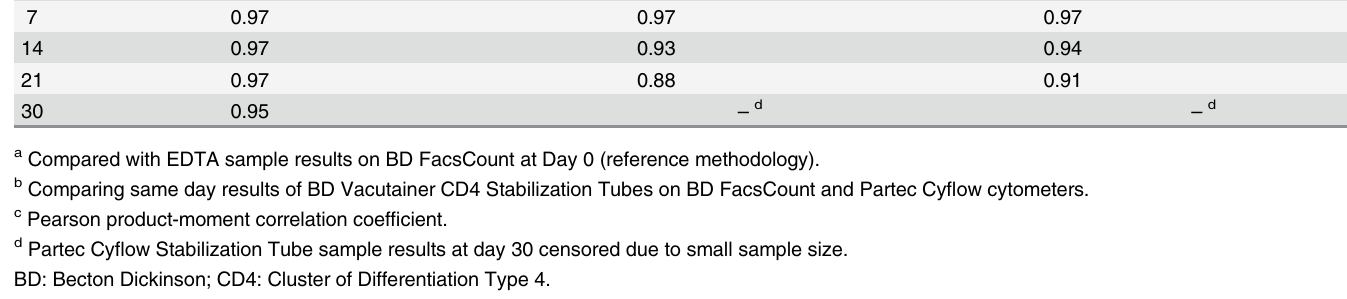
a Compared with EDTA sample results on BD FacsCount at Day 0 (reference methodology). b Comparing same day results of BD Vacutainer CD4 Stabilization Tubes on BD FacsCount and Partec Cy fl ow cytometers. c